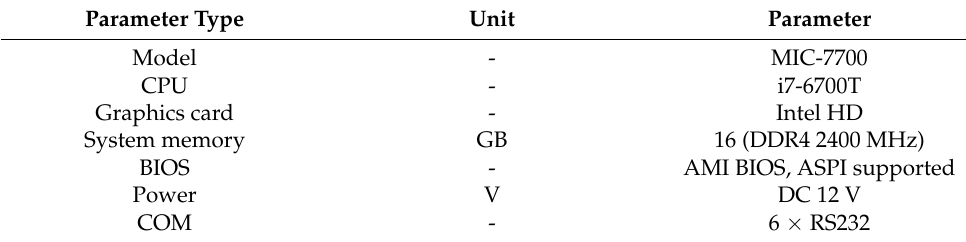
Table 2. Industrial computer parameters.